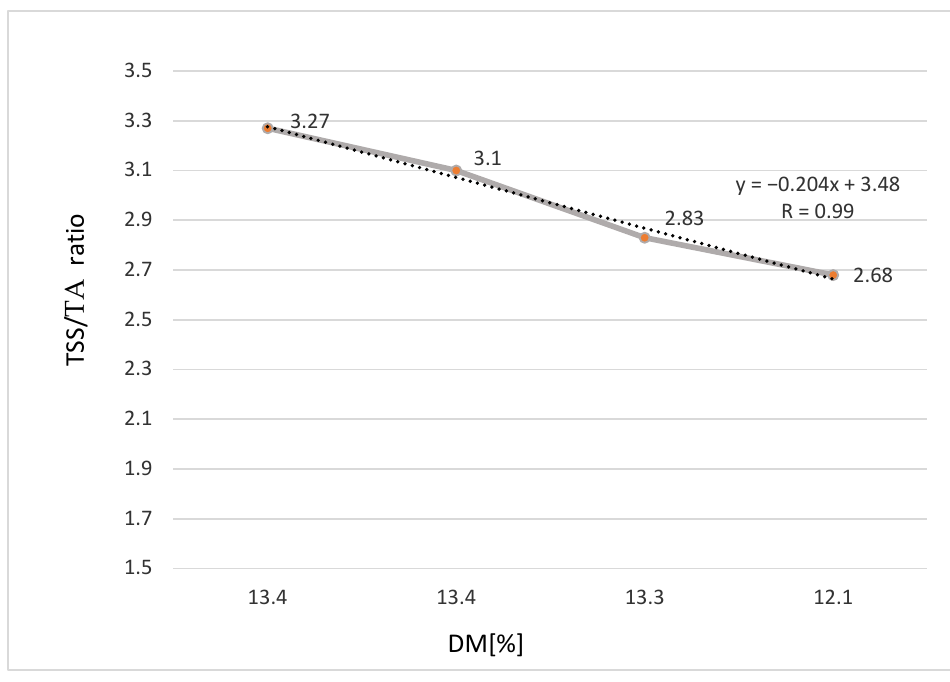
Figure 11. The dry matter versus TSS/TA ratio of Idared apples.